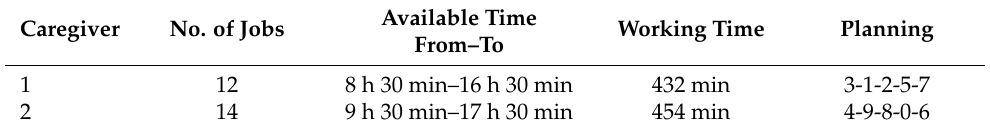
Table 6. Results of instance HHC p 10_ c